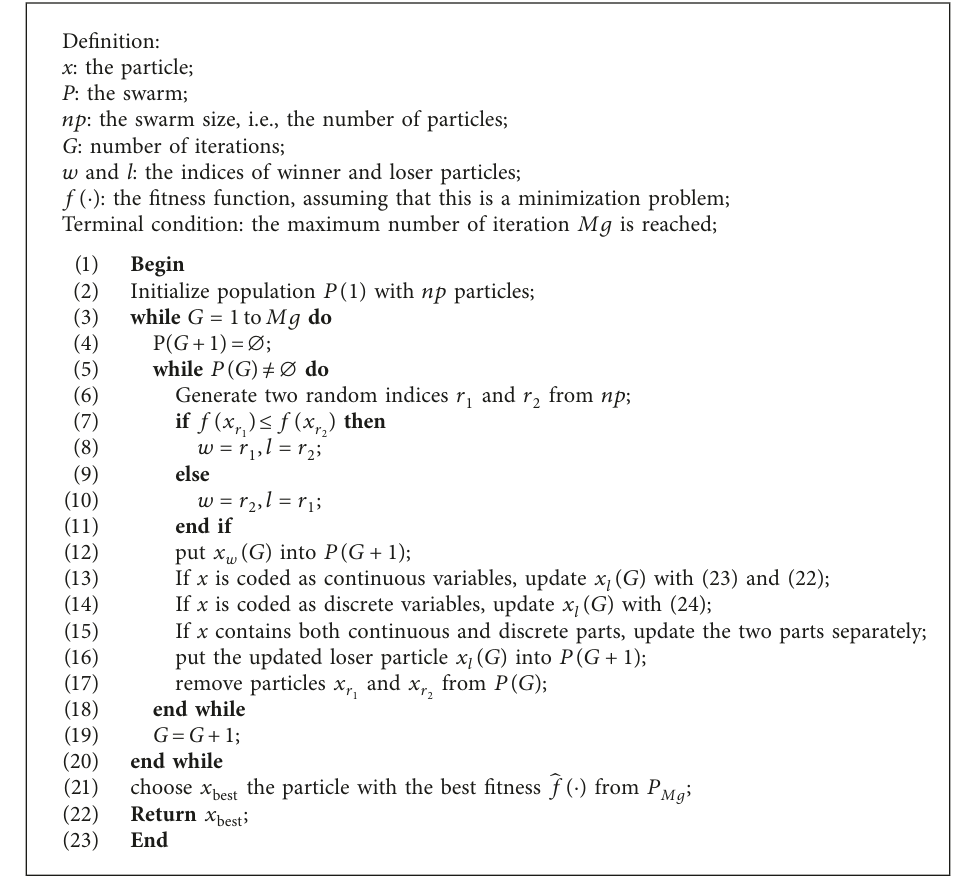
A LGORITHM 1: Pseudo code of the CSO